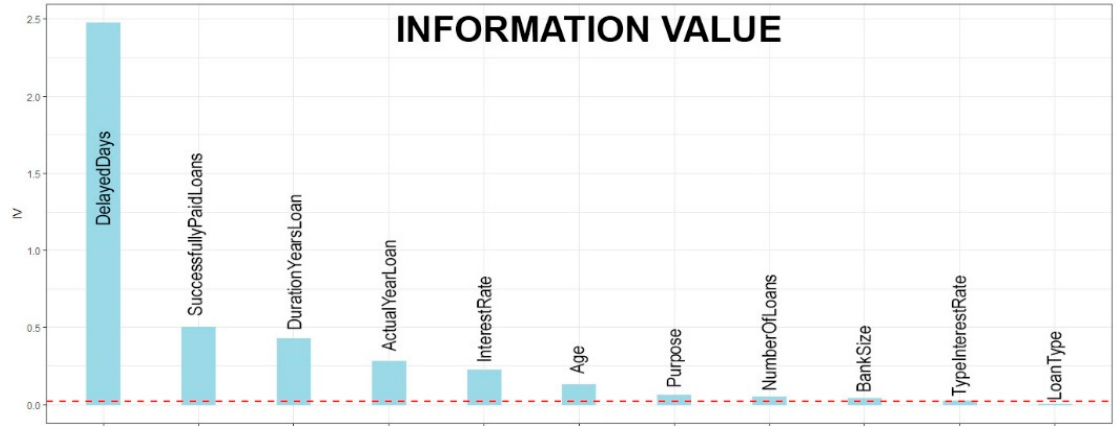
Figure 8. Information value.